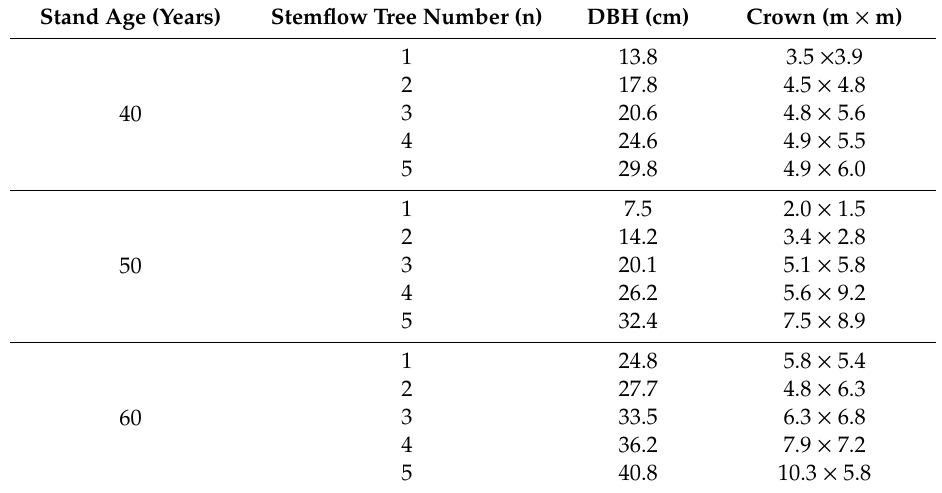
Table 2. Basic information of 15 monitored trees for stemflow in 40-, 50-, 60-year-old Chinese pine stands. Stand Age (Years) Stemflow Tree Number